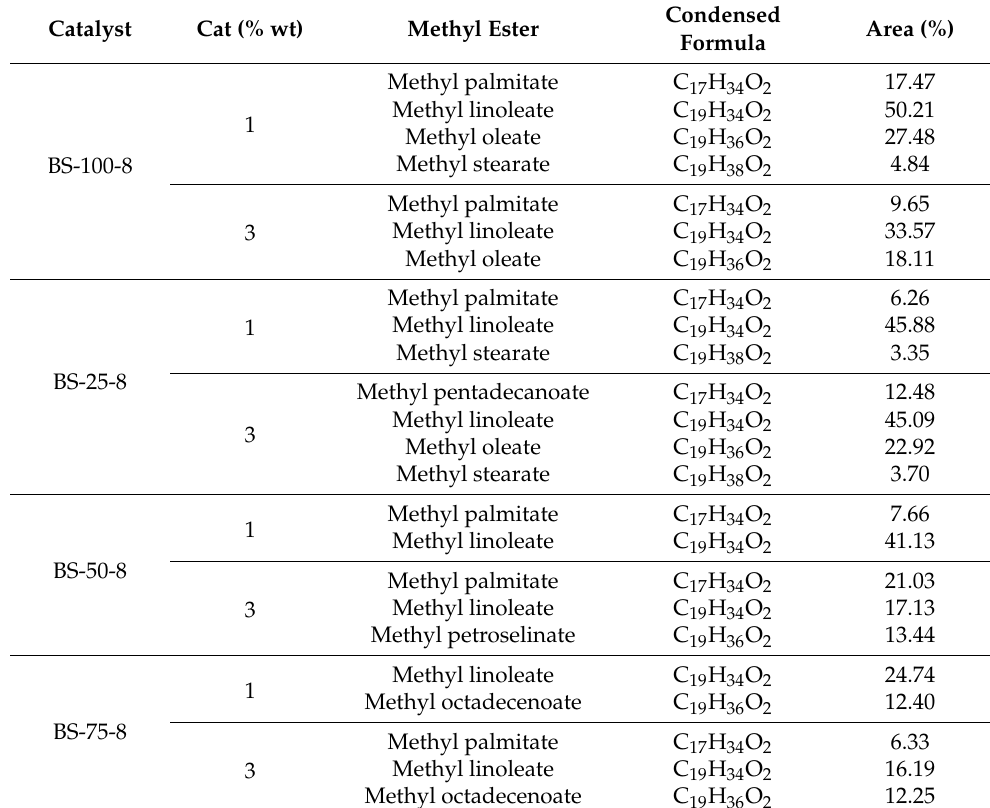
Table 5. GC–MS analysis of the biodiesel produced using the catalysts BS-100-8, BS-25-8, BS-50-8 and BS-75-8 at 1 and 3